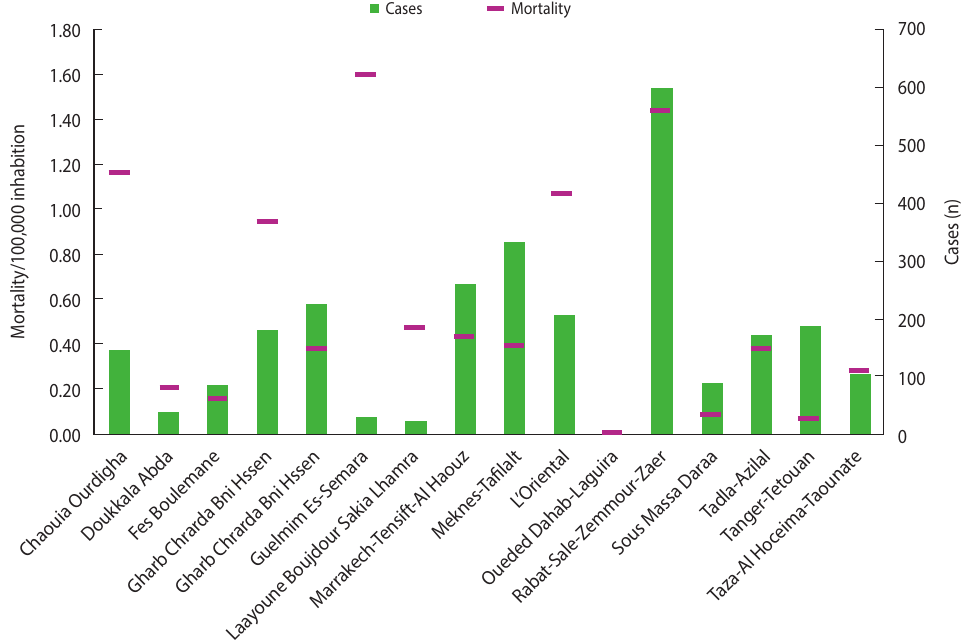
Figure 2. Distribution of voluntary poisoning cases (n=2,690) by pesticides according to region and mortality